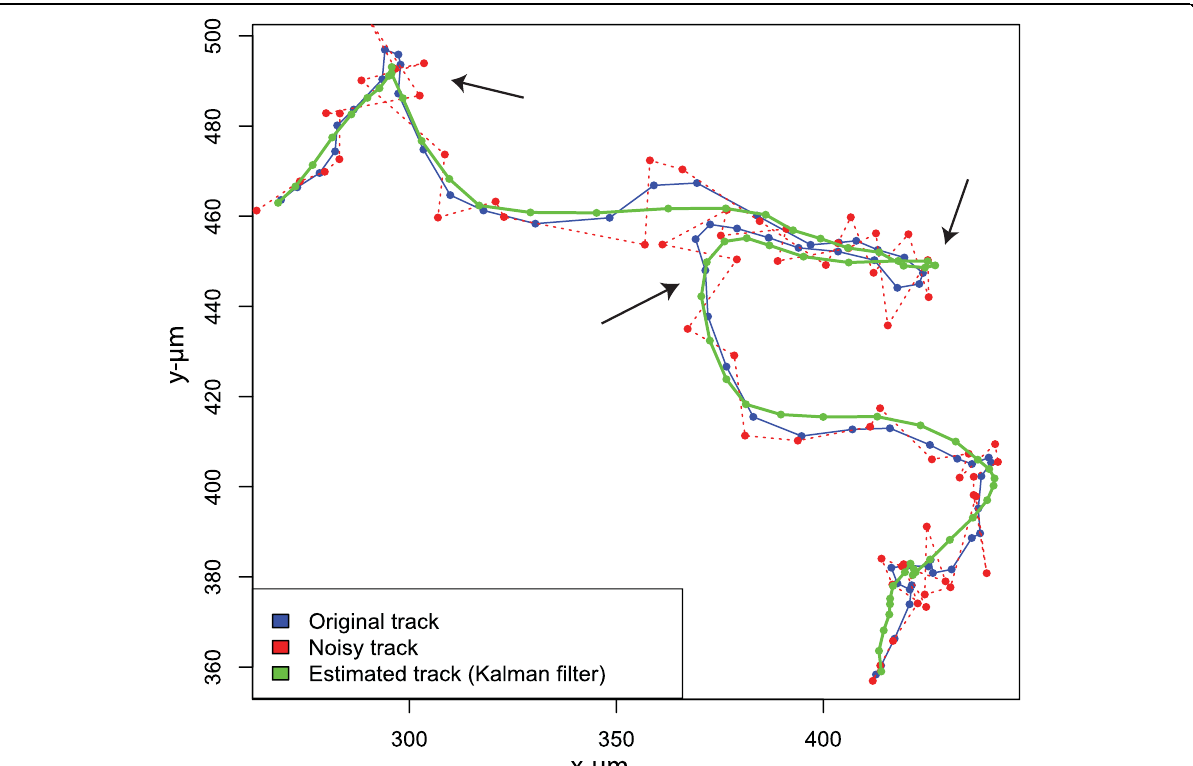
Figure 3 Kalman filter tracked cell path . The blue line displays the “ ground truth ” cell path without any influence of noise. The track was taken from the set of smoothed manual tracks of the first video file. The red dots indicate the noisy measurements, which were varied within a standard deviation of five pixels around the original (blue) path. The dashed red line shows the track that would result from taking the noisy measurements as real centroid positions. The track varies strongly around the original blue track. The green line displays the track derived by the Kalman Filter implemented in this project. A main part of the noise is successfully filtered with our approach so that the Kalman track appears much smoother than the track from the noisy measurement. Note that the KF with constant velocity model also performs well at major turning points of the trajectory (black